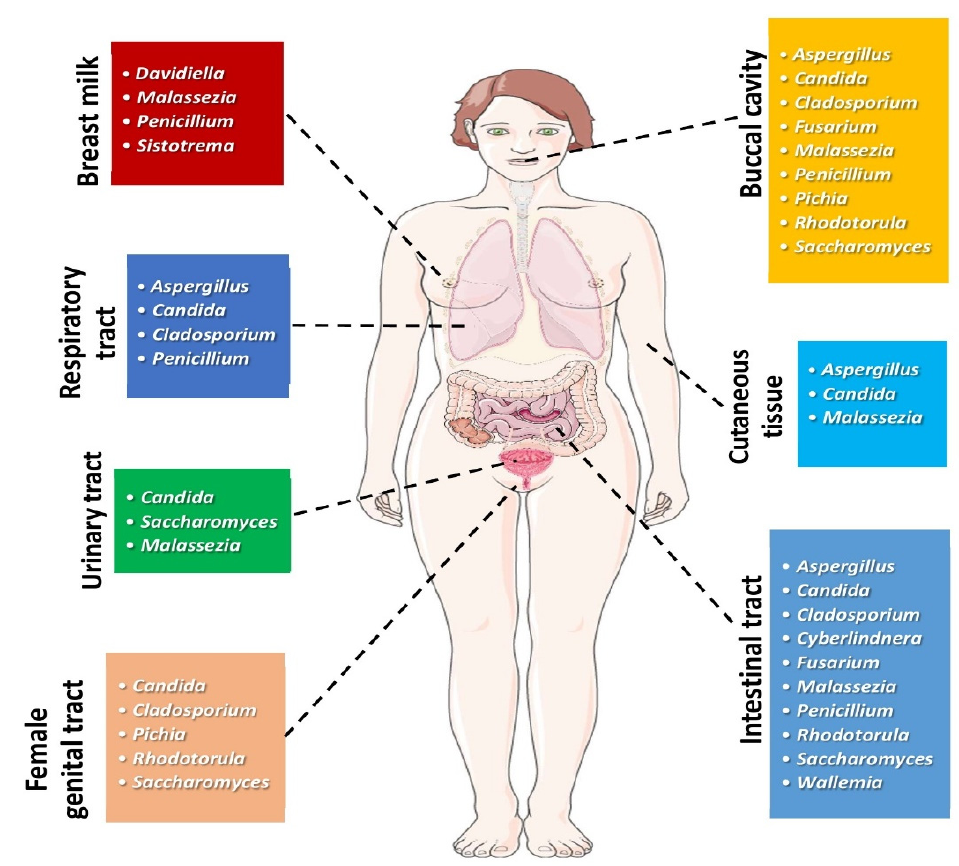
Figure 1. Most common genera of fungi found in different human body sites under physiologic conditions. (All images originate from the free medical website http://smart.servier.com/ (accessed on 25 May 2021) by Servier licensed under a Creative Commons Attribution 3.0 Unported License).